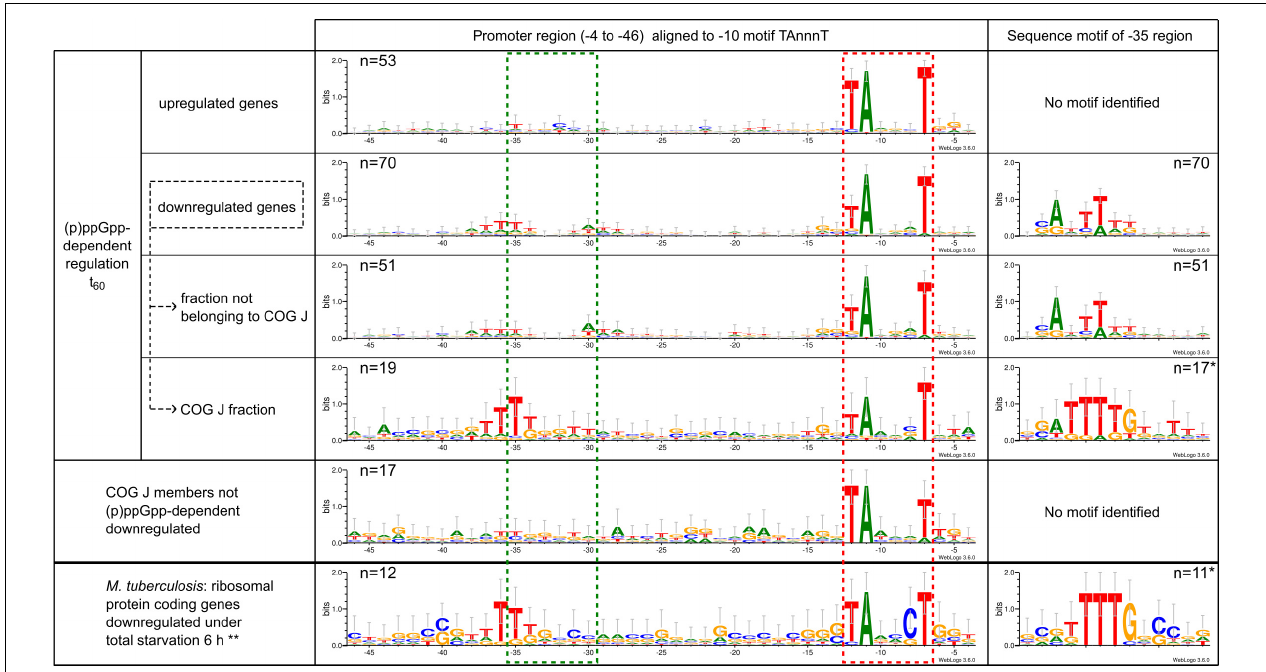
FIGURE 9 | Promoter sequence characteristics of C. glutamicum gene showing similar transcriptional regulation in the context of (p)ppGpp-dependent response to starvation stress. The − 10 motif was identified using Improbizer (Ao et al., 2004) and the sequence aligned with this hexamer was displayed with Weblogo 3 (Crooks et al., 2004) as sequence logo from position − 46 to − 4. The stack height corresponds to the sequence conservation, measured in bits, and the height of each letter corresponds to the relative frequency of the corresponding nucleic acid at that position. The location of the − 10 region is marked as a red dotted box and the − 35 region as a green dotted box. In addition, the Improbizer tool was used for the identification of conserved − 35 motifs. The respective region is also illustrated as a sequence logo after alignment of the promoter sequences to the identified motif. ∗ Promotor sequences for which no − 35 motif could be identified by Improbizer were not taken into account for the presentation of the − 35 motif, resulting in a reduced sample size. ∗∗ Ribosomal proteins showing negative transcriptional regulation in M. tuberculosis WT after 6 h of total starvation exposure (Dahl et al., 2003); TSS detection was based on a 5 (cid:48) enriched RNAseq dataset by Schneefeld et al.